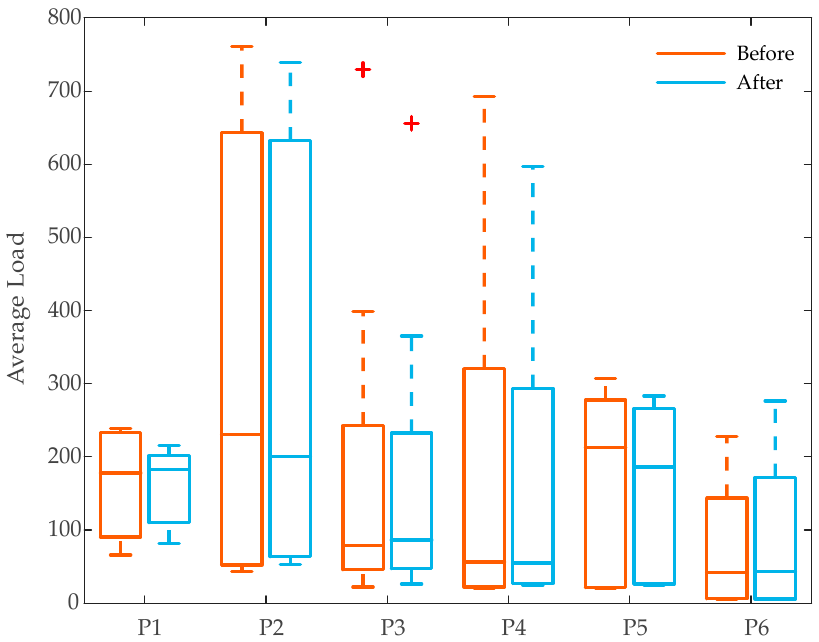
Figure 16. The average load consumption before and after enrolling in ESM.